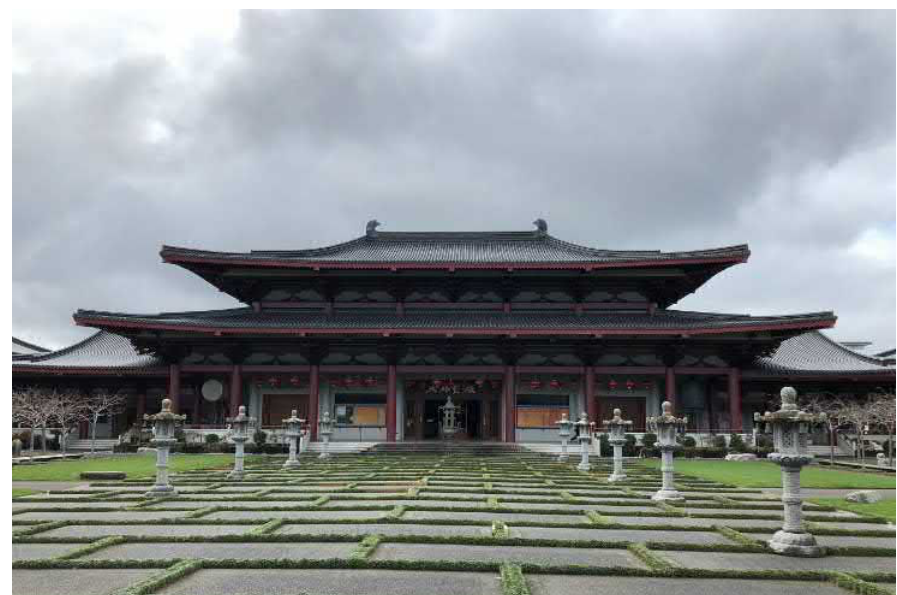
Figure 3: Fo Guang Shan Buddhist Temple, Auckland, 2018. (Photo by M. Mullins)